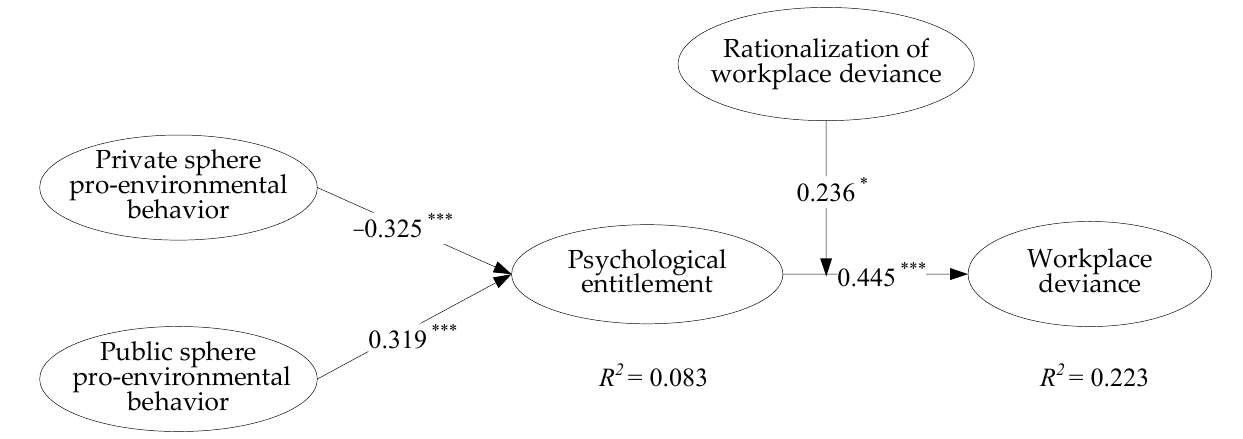
Figure 3. SEM results. Note : * p < 0.05, *** p < 0.001 .